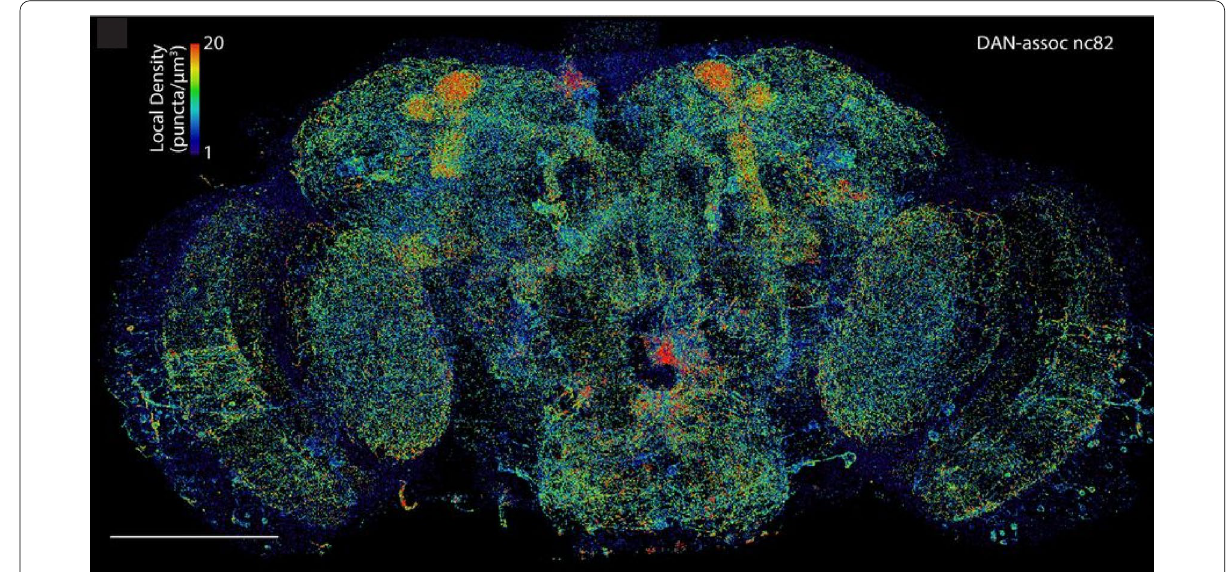
Fig. 4 Combining proExM and lattice light sheet microscopy achieves whole-brain imaging of Drosophila with sub-100 nm resolution. Scale bar, 100 μm. (From Gao et al. [70]. Reprinted/adapted by permission from AAAS)